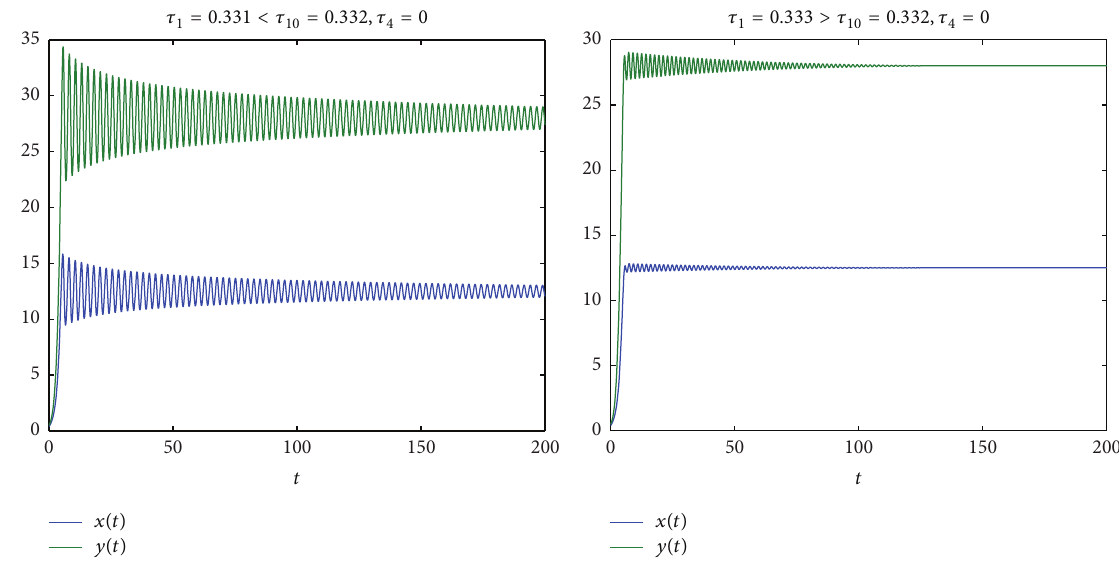
Figure 3: MATLAB simulation shows that system (115) undergoes a Hopf bifurcation at 𝐸 ∗ for 𝜏 1 = 0.333 > 𝜏 10 = 0.332 with 𝜏 4 = 0 and initial value “1.2,